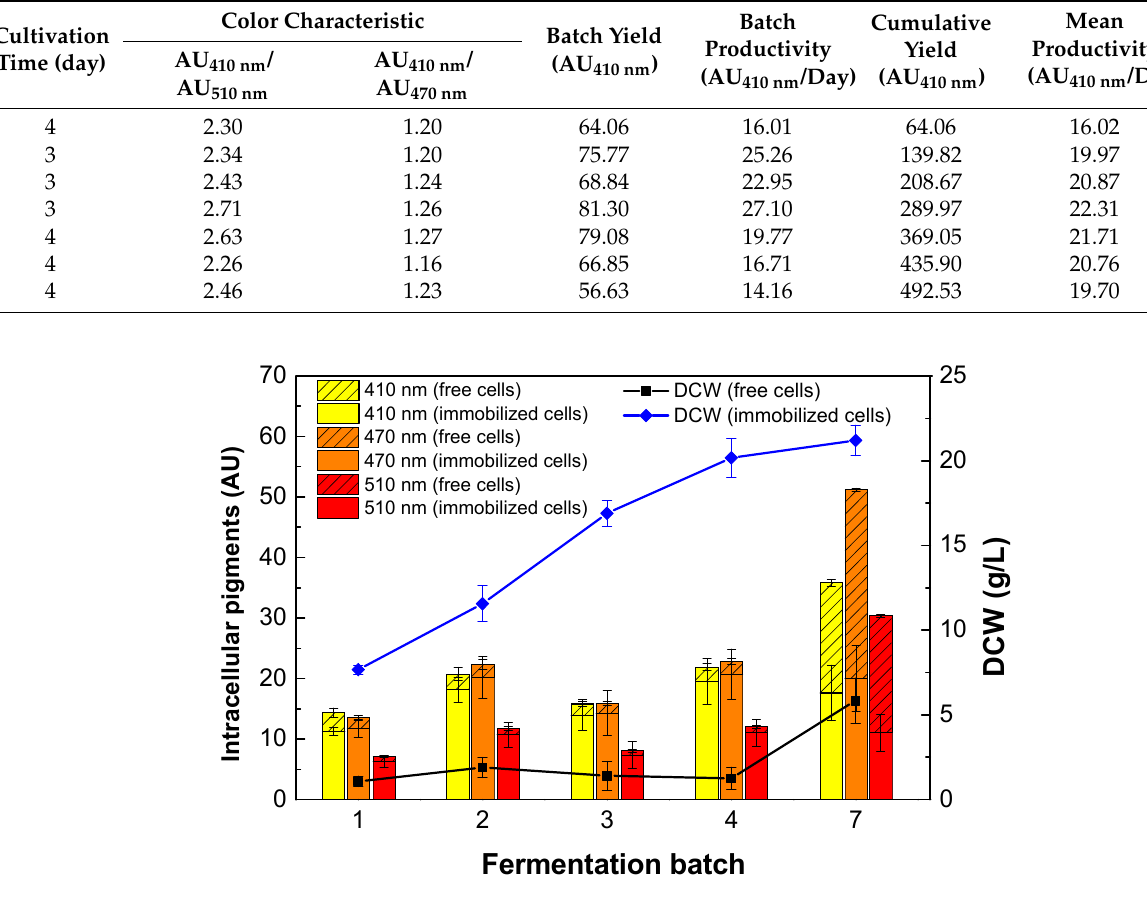
Figure 6. Biomass and intracellular pigment concentration at the end of each batch in repeated-batch extractive fermentation with immobilized cells.